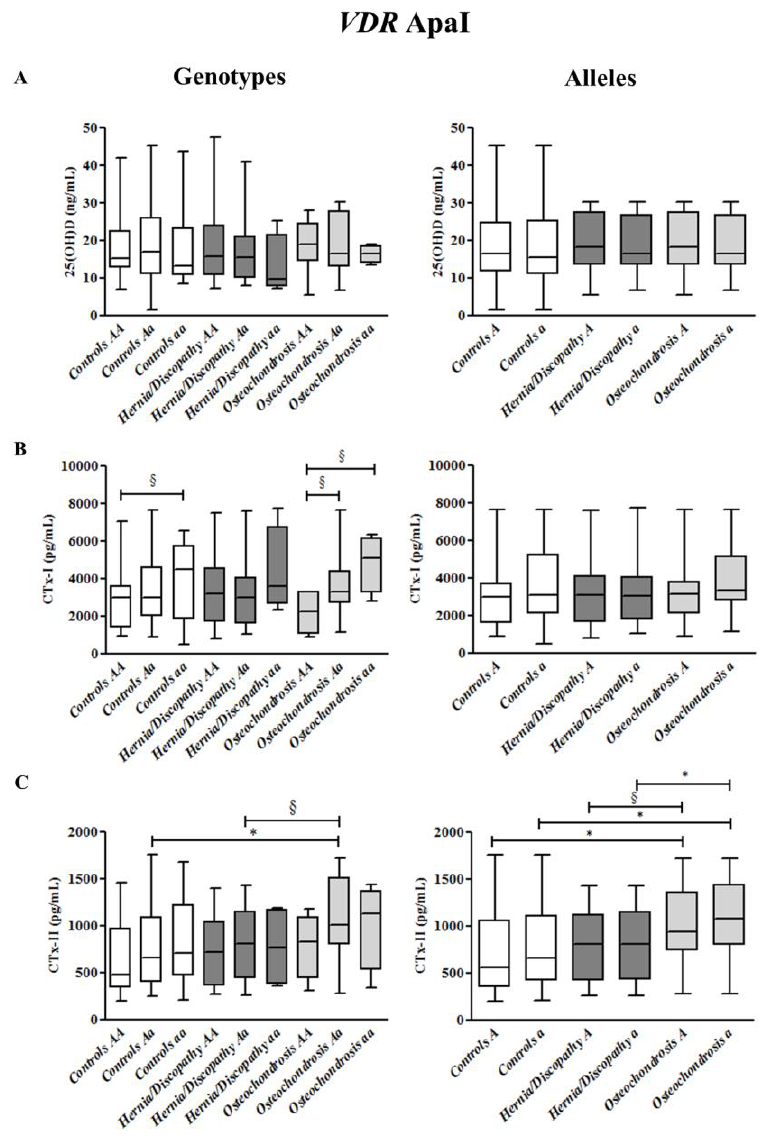
Figure 4. 25hydroxyvitamin D (25(OH)D) ( A ), cross-linked C-telopeptides of type I collagen (CTx-I) ( B ), and cross-linked C-telopeptides of type II collagen (CTx-II) ( C ) plasma concentrations in controls and in the subgroups of patients with hernia/discopathy and osteochondrosis, distributed according to ApaI VDR genotypes/alleles. The box and whisker plots show the median, 25th and 75th percentile (interquartile) (the box), and minimum and maximum value (the whiskers). * p < 0.05. § indicates a tendency.